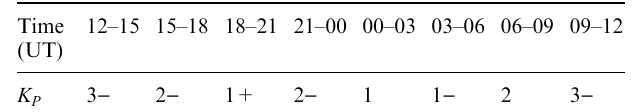
Table 1. K P indices between May 2, 1985 and May 3, 1985 (WDC- C2 Kyoto, 1996)